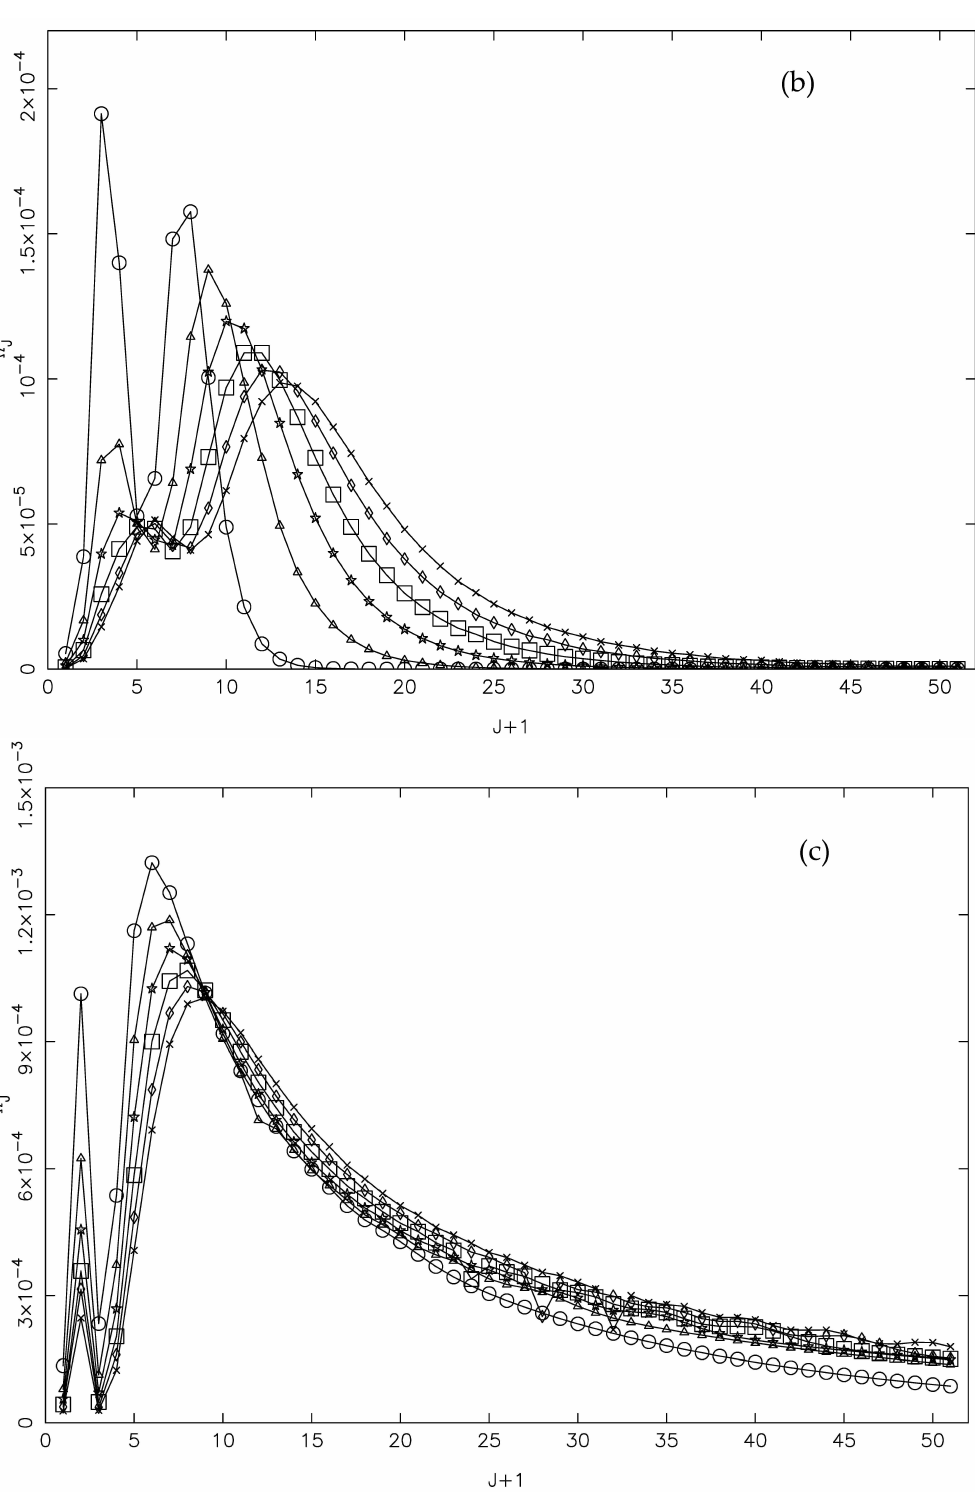
–2s2p 6 2 S 1/2 ), ( b ) 1–8 (2s 2 2p 5 3/2